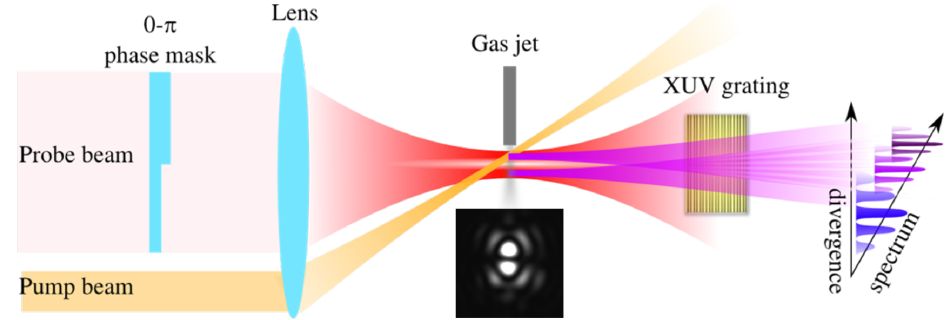
Figure 1. (Color on-line) A 0- π phase plate is used as a mode convertor for HHG phase measurement by twp-source interferometry (TSI). The inset below the gas jet shows an experimental picture of the two bright spots created at the focus of a lens with a 0- π phase plate on the LUCAlaser. One of the two sources is used as a probe of the dynamics induced by a pump beam that is overlapped only with this source. The other HHG source remains unexcited and is used as a reference. A set of micro-channel plates and a phosphor screen are placed in the flat-field of a variable groove grating that allows one to disperse the different harmonic orders in one dimension and resolve their spatial profile in the other